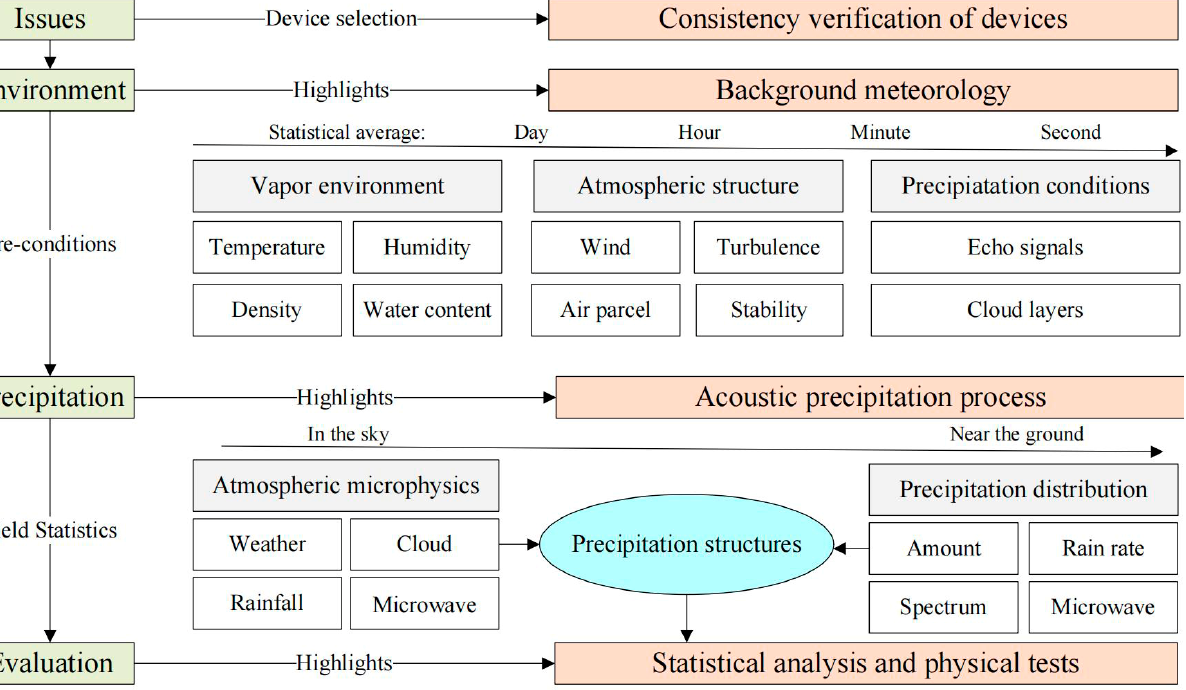
Figure 2. Meteorological measurements and effectiveness evaluation processes.